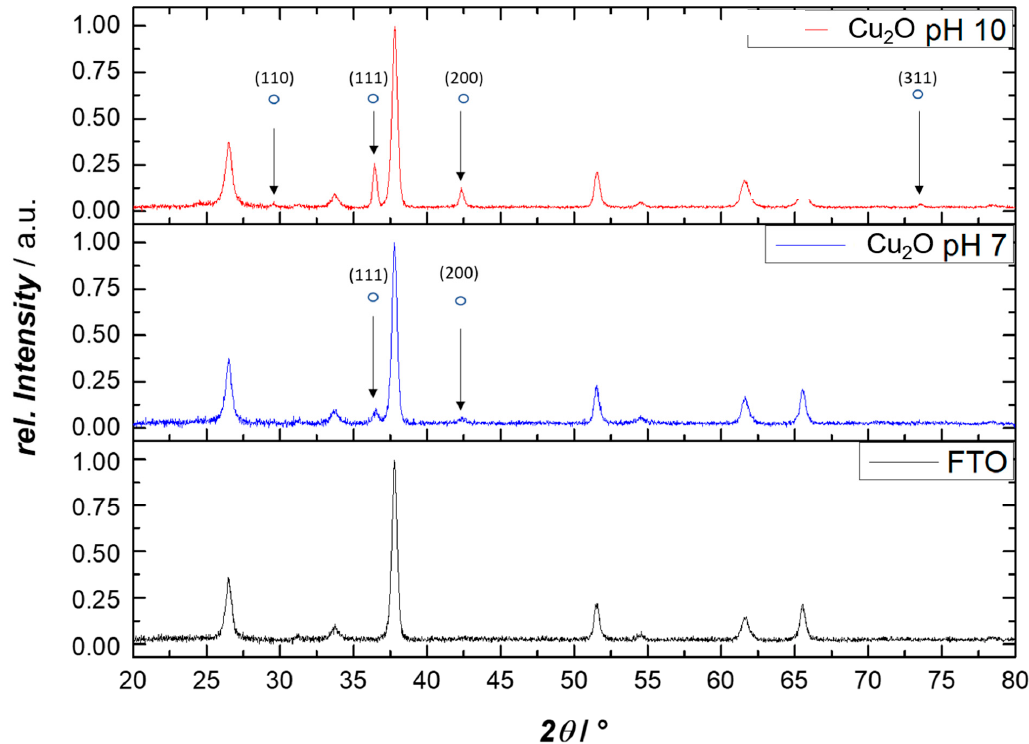
Figure 4. GIXRD pattern of the electrodeposited Cu 2 O-films deposited at pH 7 and pH 10 and the pattern of FTO as reference. Peak assignments were performed based on previously reported literature [27].